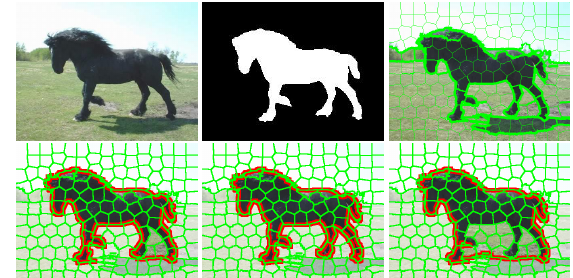
Figure 3: Segmentation example of a horse image. Top row: original image, ground-truth, and superpixel boundary edginess; Bottom row: top 3 segmentation results (the red figure boundary overlays with the superpixel segmentation image for visualiza- tion). The thickness of the boundary between superpixels corre- sponds to the average edge probability of its superpixel boundary pixels, which shows the thick edges are more likely to be the object boundaries. By comparing with ground-truth, the second result fully recovered the horse boundary.